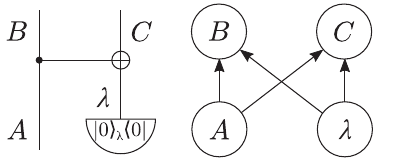
FIG. 9. Quantum realization of the coherent copy using an ancilla and quantum CNOT